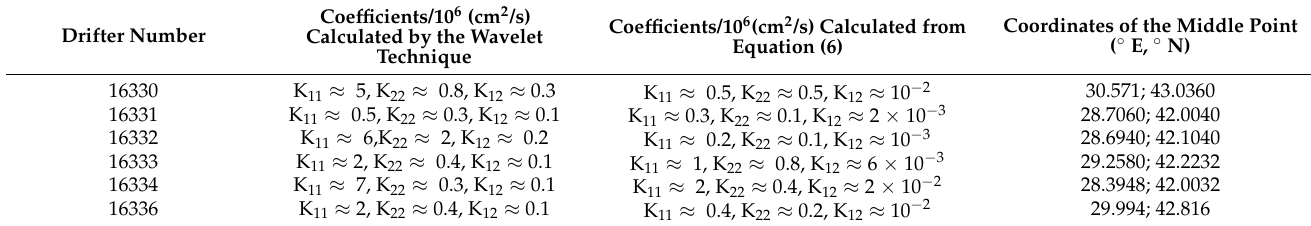
Table 2. Turbulent diffusion coefficients obtained by different methods for the first group of trajectories. Coefficients/10 6 (cm 2 /s) Coordinates of the Middle Point Coefficients/10 6 (cm 2 /s) Calculated from Drifter Number Calculated by the Wavelet ( ◦ E, ◦ N) Equation (6) Technique